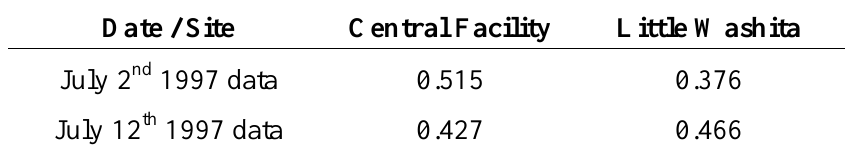
Table 1. Relationship between SAR backscatter (DN) variability as function of NDVI variability in terms of correlation coefficient (R).